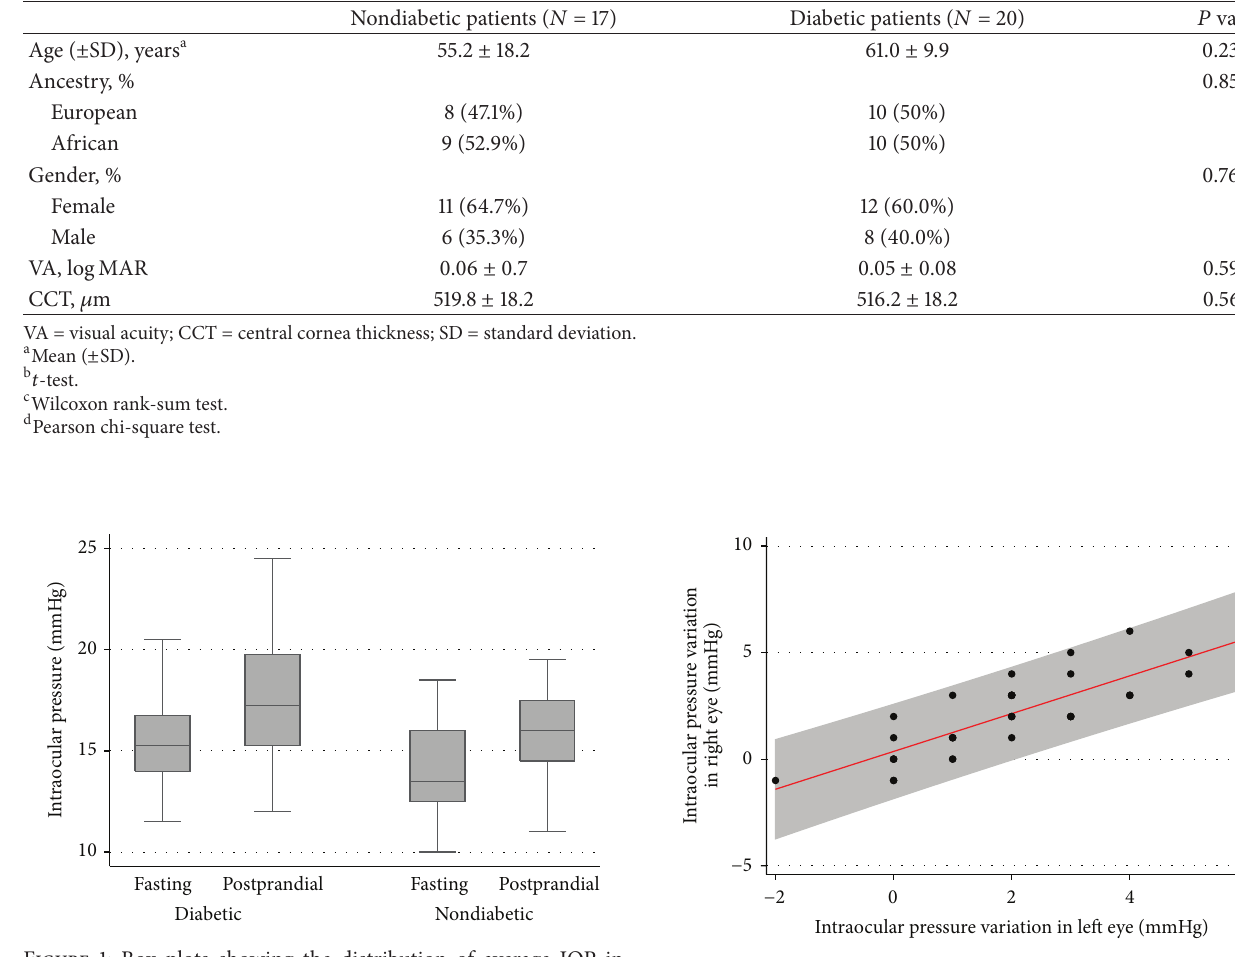
Figure 3: Scatter plot depicting the relationship between IOP variations in the right and in the left eye (shaded area represents 95% confidence interval of the